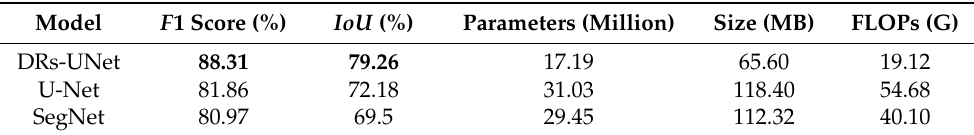
Table 4. Quantitative assessment, complexity of different models in the test